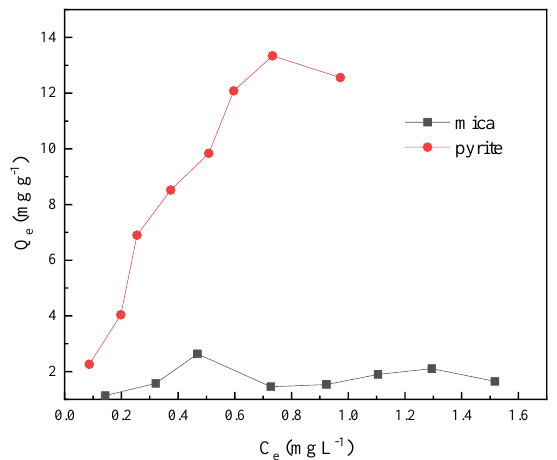
Figure 3. Equilibrium adsorption capacity of thiourea on mica and pyrite.